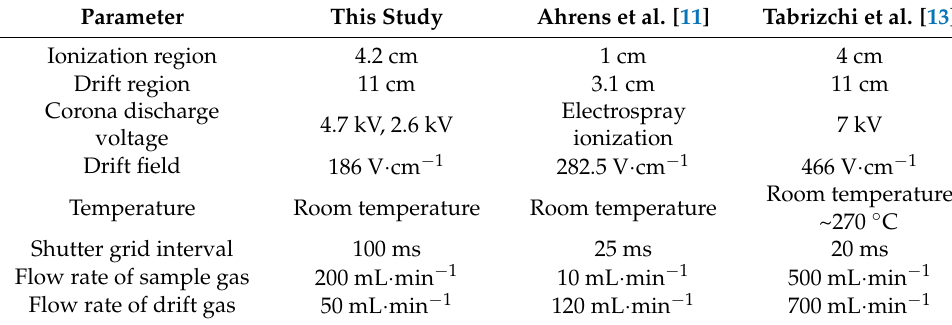
Figure 2. Arrival-time spectra of ethanol (75.2, 325.7, 601.4, and 1098.7 ppm). These spectra were measured with an electric field, E , of 186 V cm −1 . The reactant ion peak (RIP) is the background spectrum obtained from water cluster ions. Table 1. Dimensions and operating parameters of IMS.